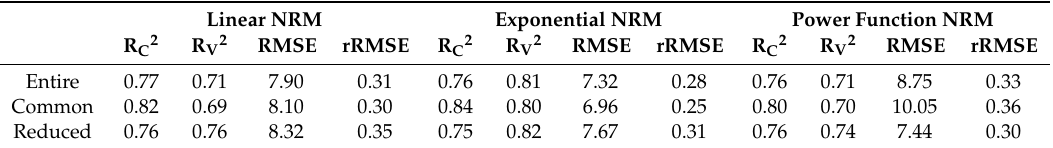
Table 4. Summarized mean values for nitrogen regression models (NRMs) based on two-step